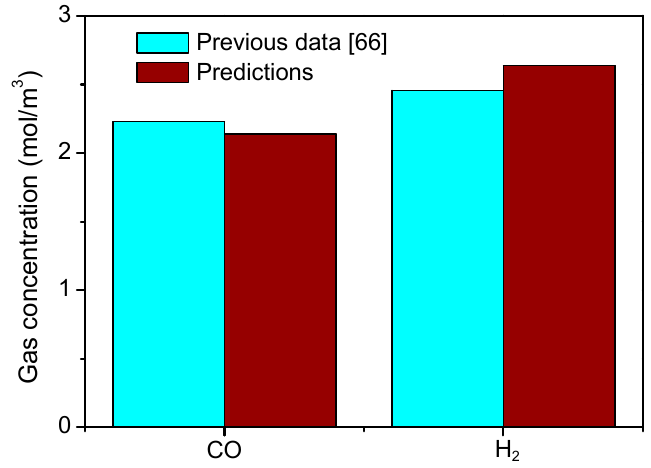
Figure 5. Comparison of the computed exhaust concentrations from steam-char gasification reaction over sand with the previous data: T 0 = 1173 K, U / U mf = 4.5.